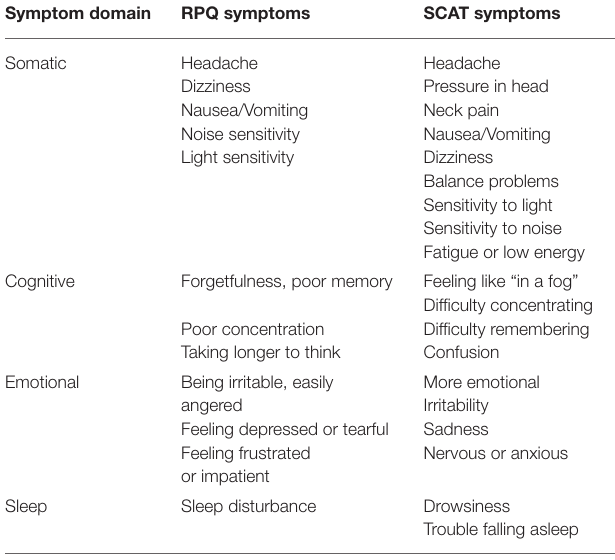
TABLE 1 | Symptom domain groupings and the corresponding Rivermead Post-Concussion Questionnaire (RPQ) and Sports Concussion Assessment Tool (SCAT) symptoms.